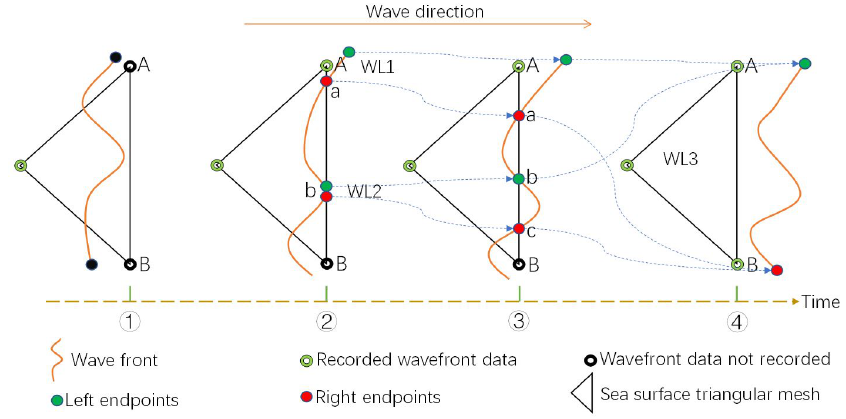
Figure 5. Top-down view of the wavefront cross-mesh edge and WL computation.